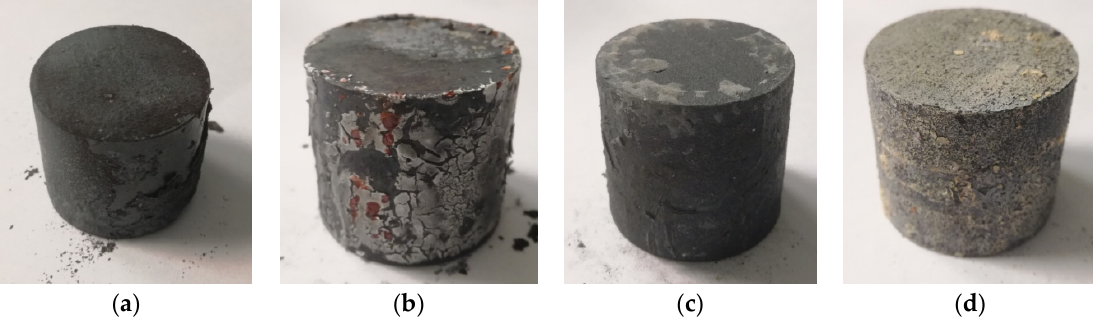
Figure 3. Pictures of the samples after heating T a = 1200 °C in the time of t a = 5 min after cooling; ( a ) no coating on, ( b ) Berulite coating, ( c ) Bonderite coating and ( d ) Condursal coating.